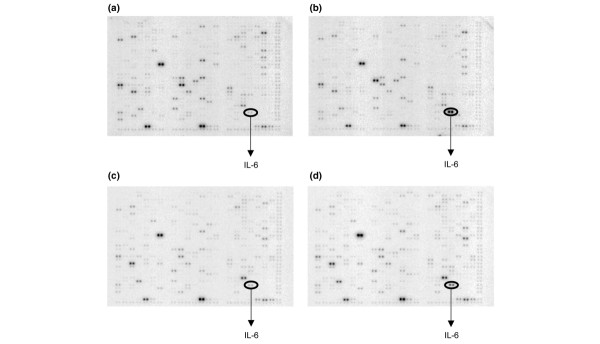
Gene expression patterns in rheumatoid arthritis (RA) and osteoarthritis (OA) fibroblast-like synoviocytes (FLSs). Total RNA of control RA (a) and OA FLSs (c) and of RA (b) and OA FLSs (d) stimulated for 4 hours with protein I/II were first reverse-transcribed and 32P-labeled and then hybridized to Atlas human cancer cDNA expression arrays. Arrows indicate double spots representing IL-6.